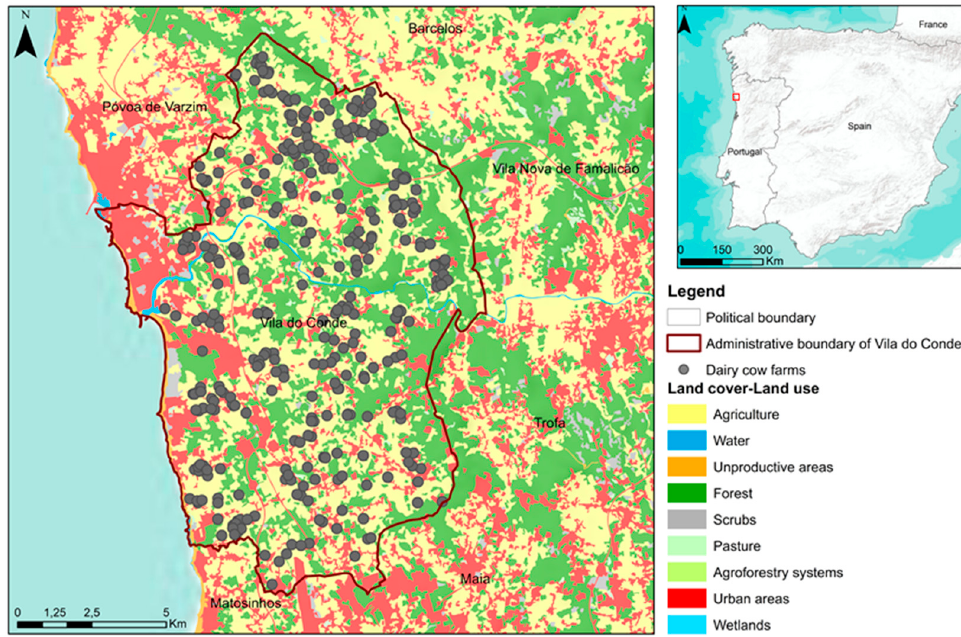
Figure 1. Spatial research unit of Vila do Conde municipality (NW